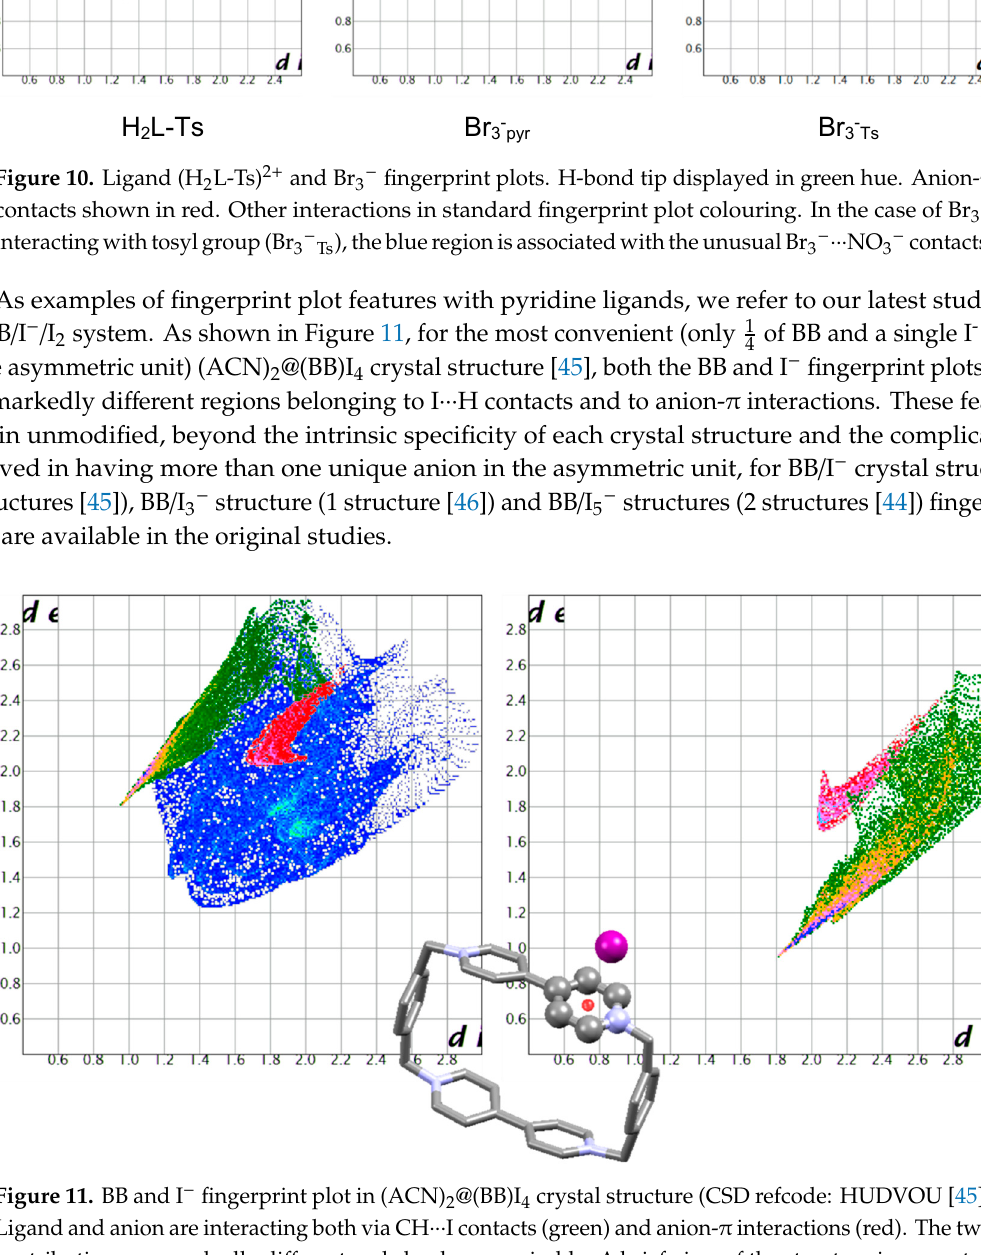
Figure 11. BB and I − fingerprint plot in (ACN) 2 @(BB)I 4 crystal structure (CSD refcode: HUDVOU [45]). Ligand and anion are interacting both via CH ··· I contacts (green) and anion- π interactions (red). The two contributions are markedly different and clearly recognisable. A brief view of the structure is presented for reference.